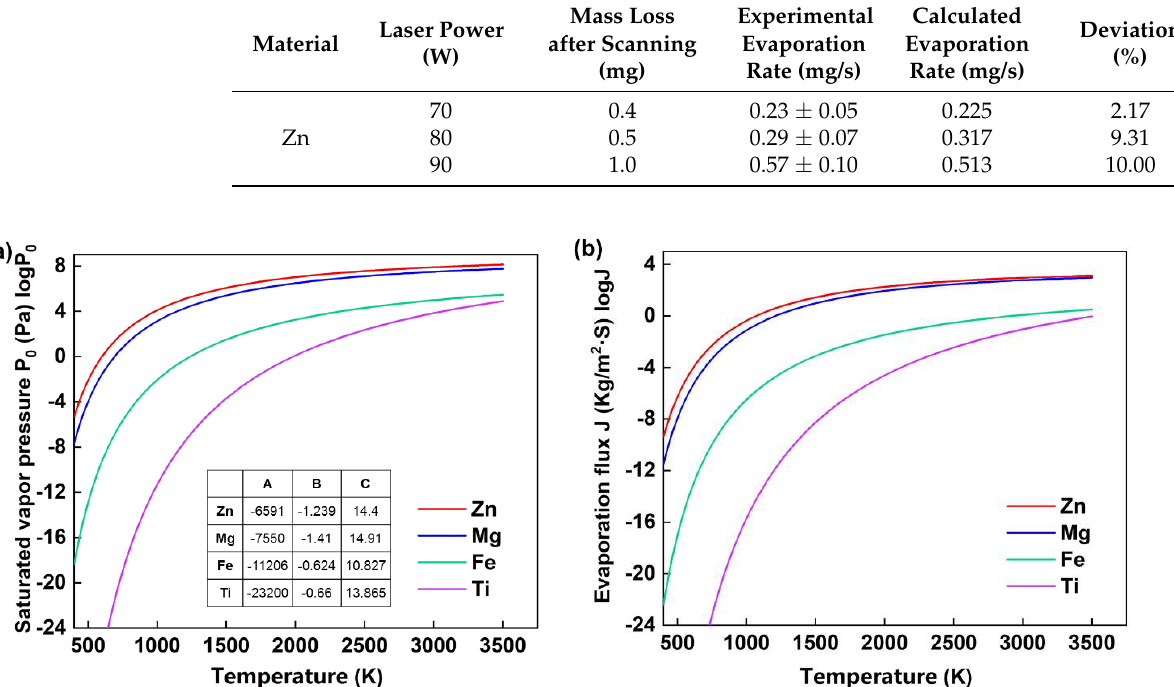
Figure 7. Saturated vapor pressure ( a ) and evaporation flux ( b ) based on the Langmuir model.